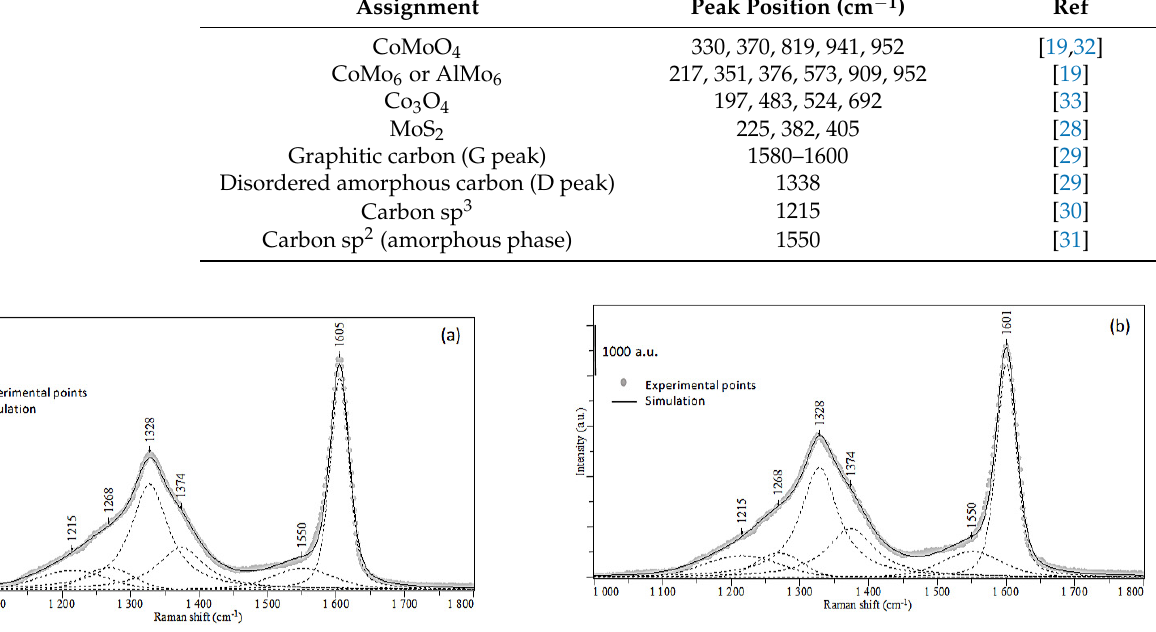
Figure 5. Raman spectrum of the spent catalyst ( a ) and extracted coke by HF ( b ), with the corresponding curve fitted bands. The ID/IG ratio corresponding to the aged HDS catalyst is equal to 1.4., which corresponds to a carbon crystal size of ca. 16